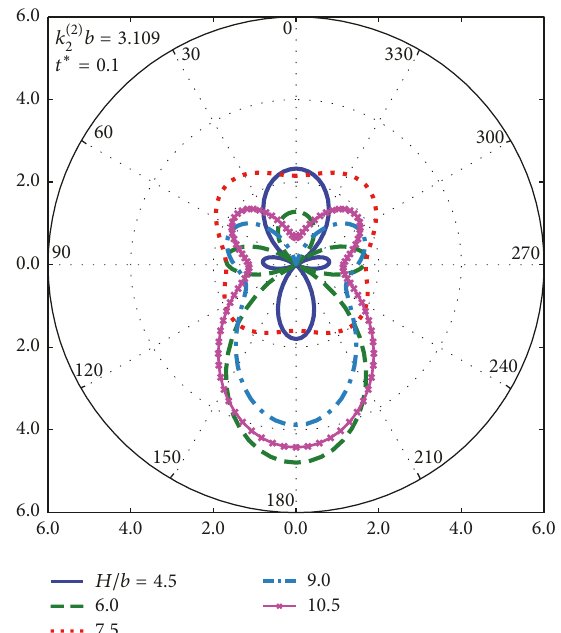
Figure 11: Radial displacement (𝑢 ∗ 𝑟 ) versus polar angle at 𝑟 = 𝑏 for different depths (𝐻/𝑏) for a tunnel in hard soil.